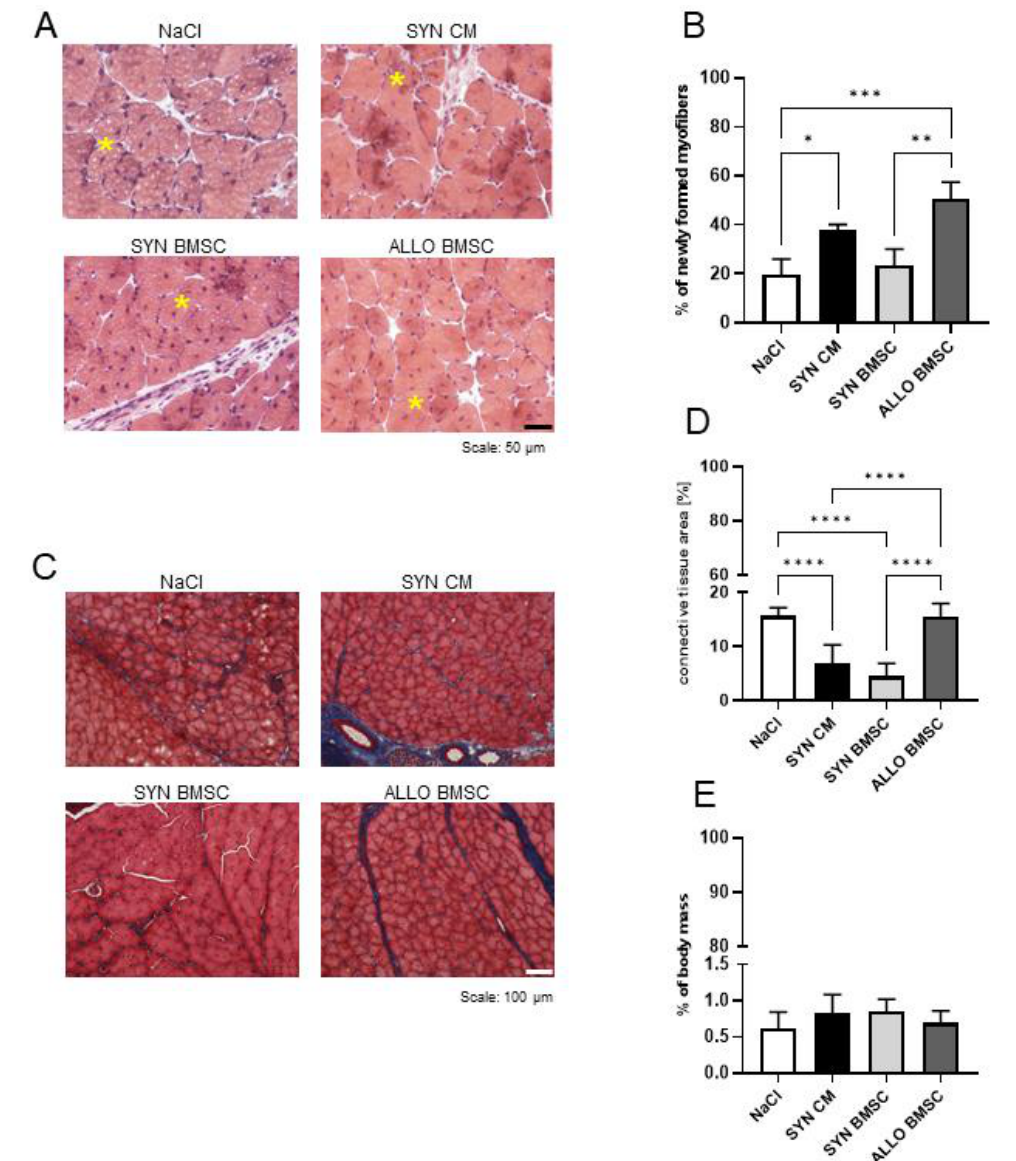
Figure 3. Regeneration of mouse skeletal muscles injected with NaCl or SYN CM or SYN or ALLO BMSCs. ( A ) Hematoxylin-eosin-stained sections of regenerating muscles injected with NaCl, SYN CM, SYN or ALLO BMSCs, analyzed on day 14 after injury. Representative newly formed myofibers with centrally localized nuclei are marked with yellow asterisks. Scale bar: 100 μm. ( B ) Numbers of newly formed myofibers in the regenerating muscle injected with NaCl or SYN CM or SYN or ALLO BMSCs, analyzed on day 14 after injury. ( C ) Masson ’ s trichrome stained sections of regenerating muscles injected with NaCl or SYN CM or SYN or ALLO BMSC, analyzed on day 14 after injury. Skeletal muscle in pink, connective tissue in blue. Scale bar: 100 μm . ( D ) Proportion of connective tissue area to whole muscle area in regenerating muscle injected with NaCl or SYN CM or SYN or ALLO BMSCs analyzed on day 14 after injury. ( E ) Weight of regenerating muscles injected with NaCl or SYN CM or SYN or ALLO BMSCs, analyzed on day 14 after injury, shown in proportion to mouse weight. Data found to be statistically significant are underlined on graphs and are marked with asterisks (* p < 0.05; ** p < 0.01; *** p < 0.001; **** p < 0.0001).